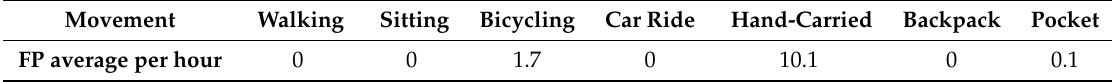
Table 3. False positive (FP) rates during daily